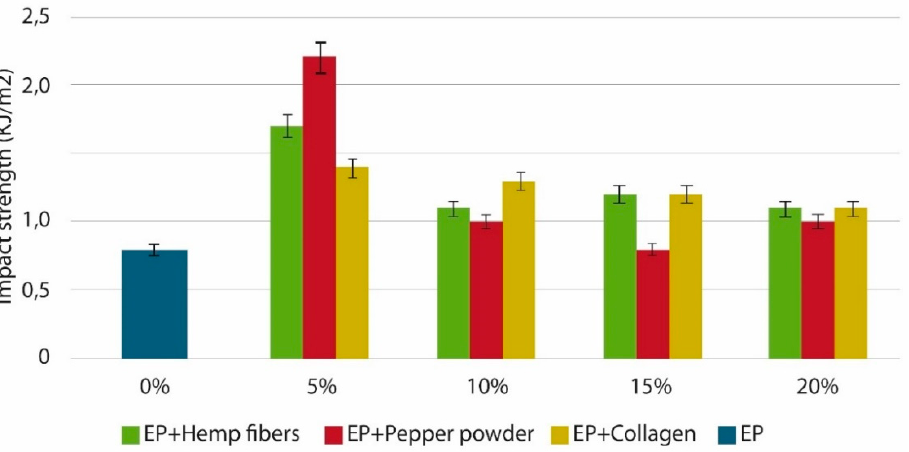
Figure 7. Impact strength of epoxy composites containing 5–20% natural filler (collagen, hemp fibers, and pepper powder [54]). Open access.